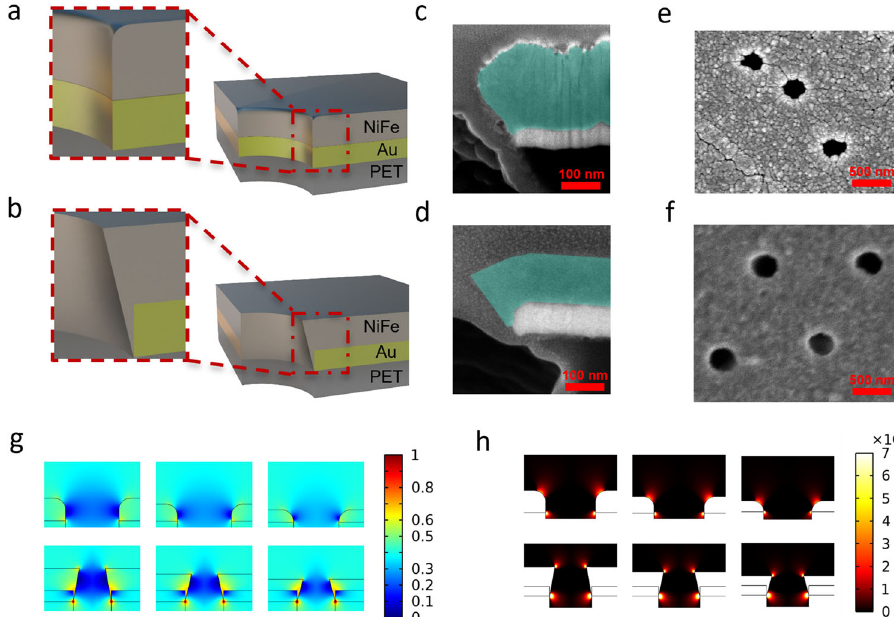
Fig. 2 Characterization and simulation of the nanopores on the sputtered and electroplated MNM. Schematic of the nanopores on ( a ) a sputtered magnetic nanoporous membrane, and ( b ) an electroplated magnetic nanoporous membrane, and the edge of the nanopore is highlighted (the fi nal thin gold layer is ignored). c Cross-section SEM images of a single nanopore on a sputtered magnetic nanoporous membrane. Note the smooth edge of the NiFe layer (blue). d Cross-section SEM images of a single nanopore on an electroplated magnetic nanoporous membrane. Note the sharp edge of the NiFe layer (blue). SEM images of the ( e ) sputtered membrane and ( f ) electroplated membrane. g Simulation of magnetic fl ux density (T) in nanopores on ideal sputtered magnetic nanoporous membrane (upper) and ideal electroplated magnetic nanoporous membranes (lower), showing the dramatic ampli fi cation of the fl ux density at the wedge on the electroplated MNM (membrane thickness left to right: 200 nm, 150 nm, 100 nm). h Simulation of the magnetic fi eld, showing the gradient of fl ux density norm square (T 2 /cm) at the wedge on both ideal sputtered magnetic nanoporous membranes (upper) and ideal electroplated magnetic nanoporous membranes (lower) (membrane thickness left to right: 200 nm, 150 nm, 100